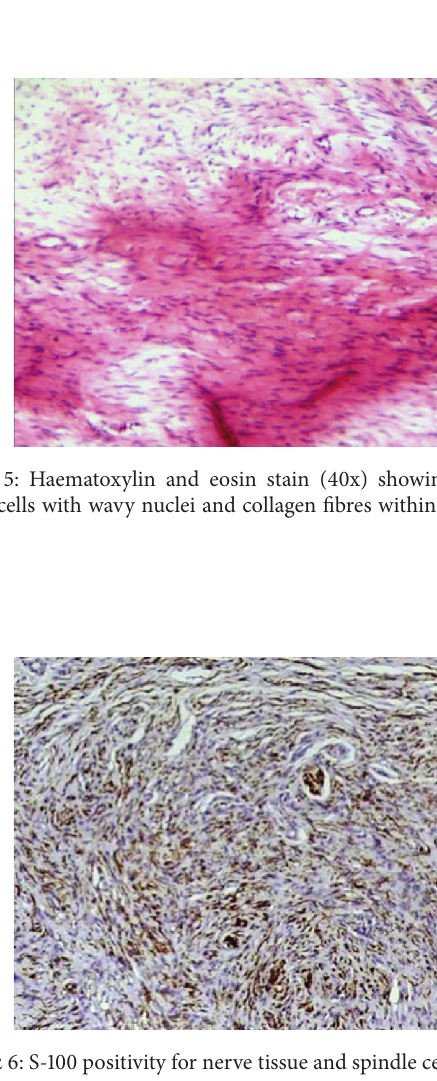
Figure4:Posteroanteriorradiographshowinghomogenousradioo- pacity with thin radiolucent border in the left mandibular posterior region.